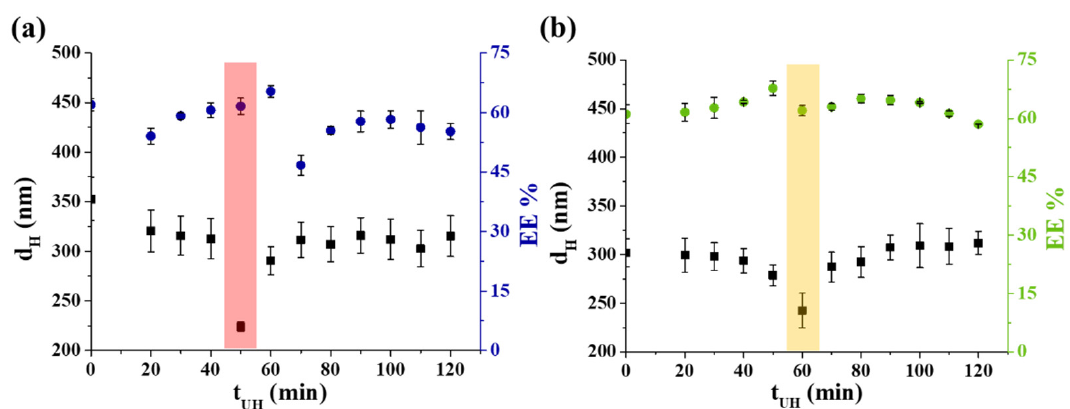
Figure 1. The hydrodynamic diameter (d H ) and the EE % of the vitamin B 1 -containing LIPs depending on the sonication time (t UH ) ( a ) at pH = 7.40 and ( b ) at pH = 3.00. In both cases the optimal treatment times are highlighted (colored columns).